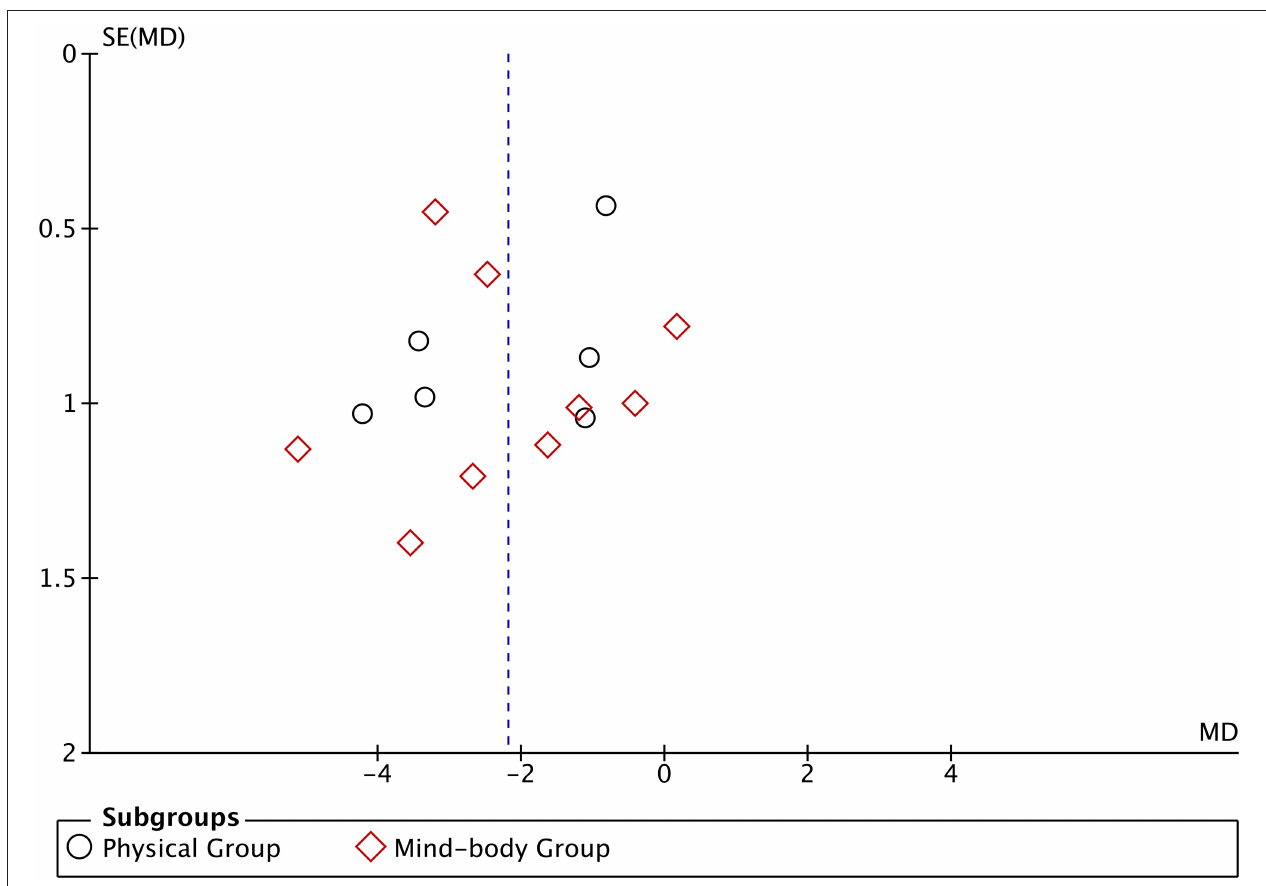
FIGURE 2 | Funnel plot assessing the publication